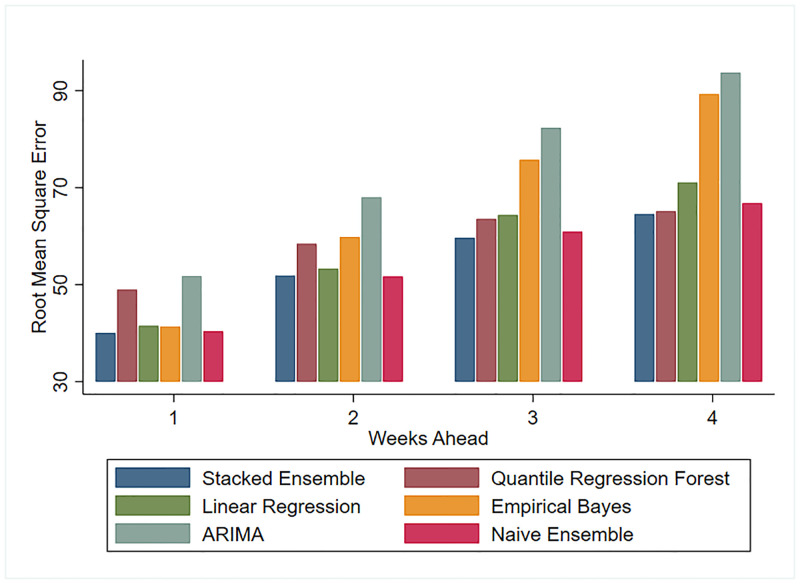
RMSE comparison for test seasons 2012-2018.